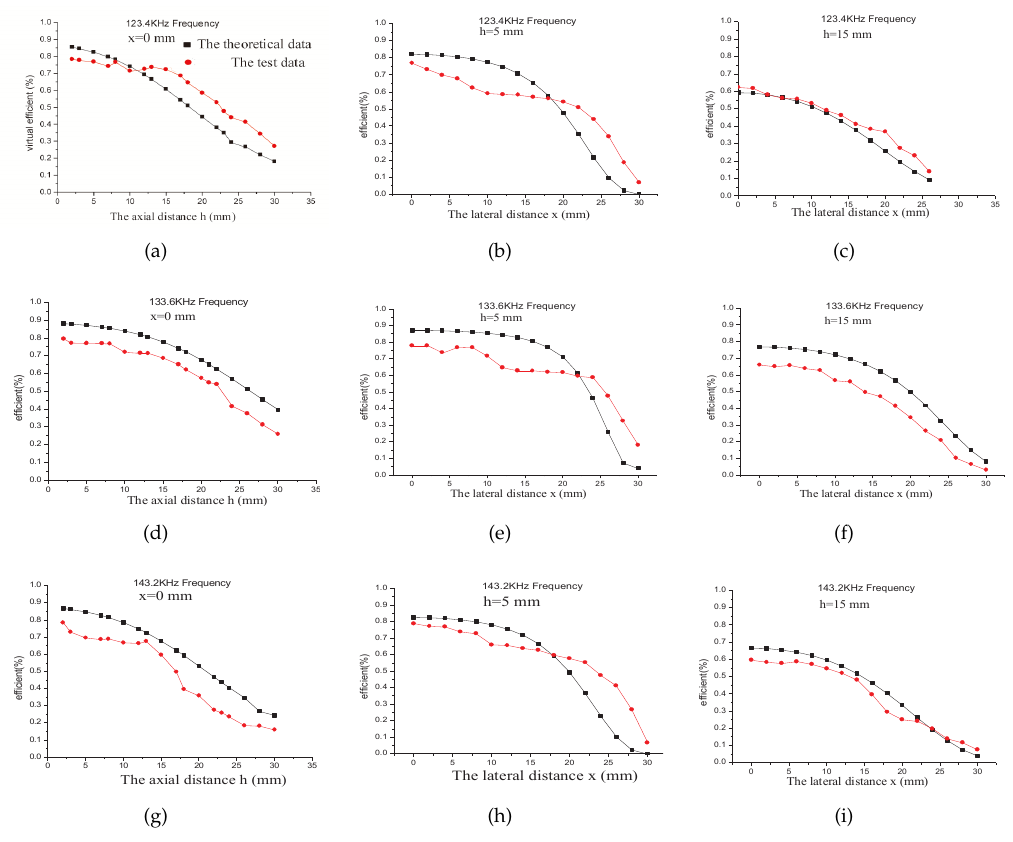
Figure 10. Changing curve of the transfer efficiency with the simulation frequency and the distance of two coils. ( a ) f = 123.4 kHz, x = 0 mm; ( b ) f = 123.4 kHz, h = 5 mm; ( c ) f = 123.4 kHz, h = 15 mm; ( d ) f = 133.6 kHz, x = 0 mm; ( e ) f = 133.6 kHz, h = 5 mm; ( f ) f = 133.6 kHz, h = 15 mm; ( g ) f = 143.2 kHz, x = 0 mm; ( h ) f = 143.2 kHz, h = 5 mm; ( i ) f = 143.2 kHz, h = 15